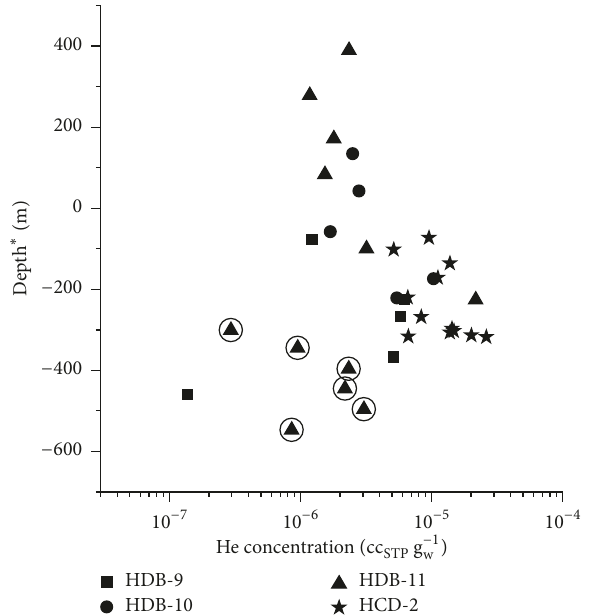
Figure 6: Relationships between 4 He concentration and 3 He/ 4 He. Figure 9 showed the example of relationships between time versus 36 Cl/Cl values and as indicated in Figure 9, in both cases, initial 36 Cl/Cl higher than ( 36 Cl/Cl) (Figure 9(a)) se (Figure 9(b)) ( 36 Cl/Cl) and lower than ( 36 Cl/Cl) se se